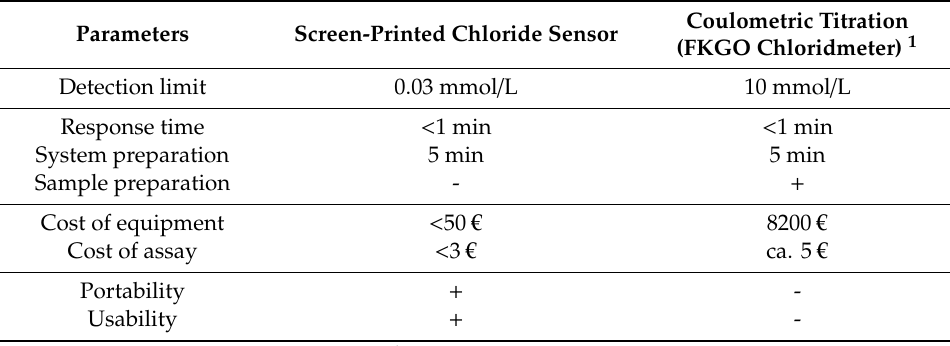
Table 2. Comparison of screen-printed chloride sensor to the standard sensor